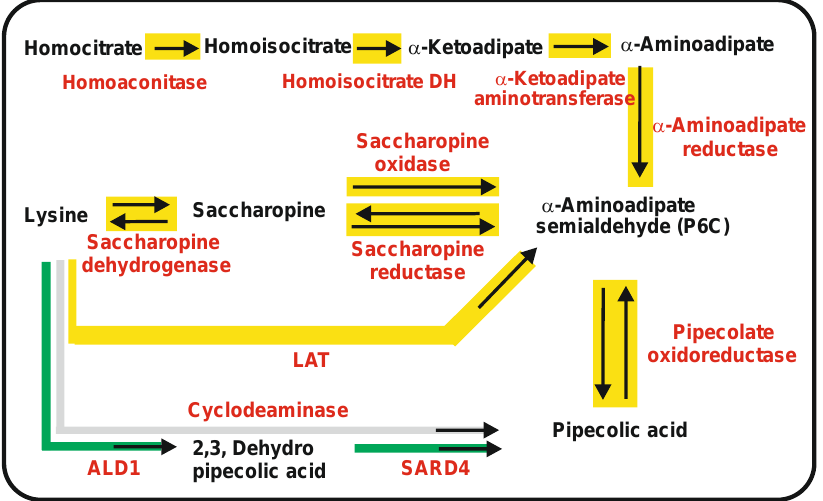
Figure 4. Biosynthetic pathways converging in the formation of pipecolic acid. The biosynthesis pathways of pipecolic acid in filamentous fungi are drawn on a yellow background. The biosynthesis pathways of pipecolic acid in bacteria are drawn on a gray background. The biosynthesis pathway of pipecolic acid in plants is drawn on a green background. Precursors, intermediates and final products of the pathways are in black letters. The enzymes are indicated in red letters. Note that pipecolic acid may be formed in a biosynthetic pathway from α -aminoadipate or from catabolism of lysine.